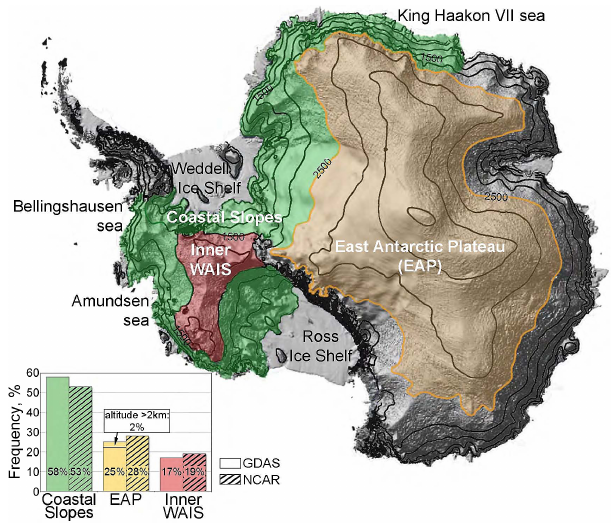
Fig. 9. Map of the different origins of air reaching WAIS Divide identified by the 4-day back-trajectory analysis and topography: East Antarctic Plateau (yellow), inner WAIS (red) and the Antarctic coastal slopes (green). Comparison between the results from anal- yses using the GDAS and NCAR meteorological archived data is